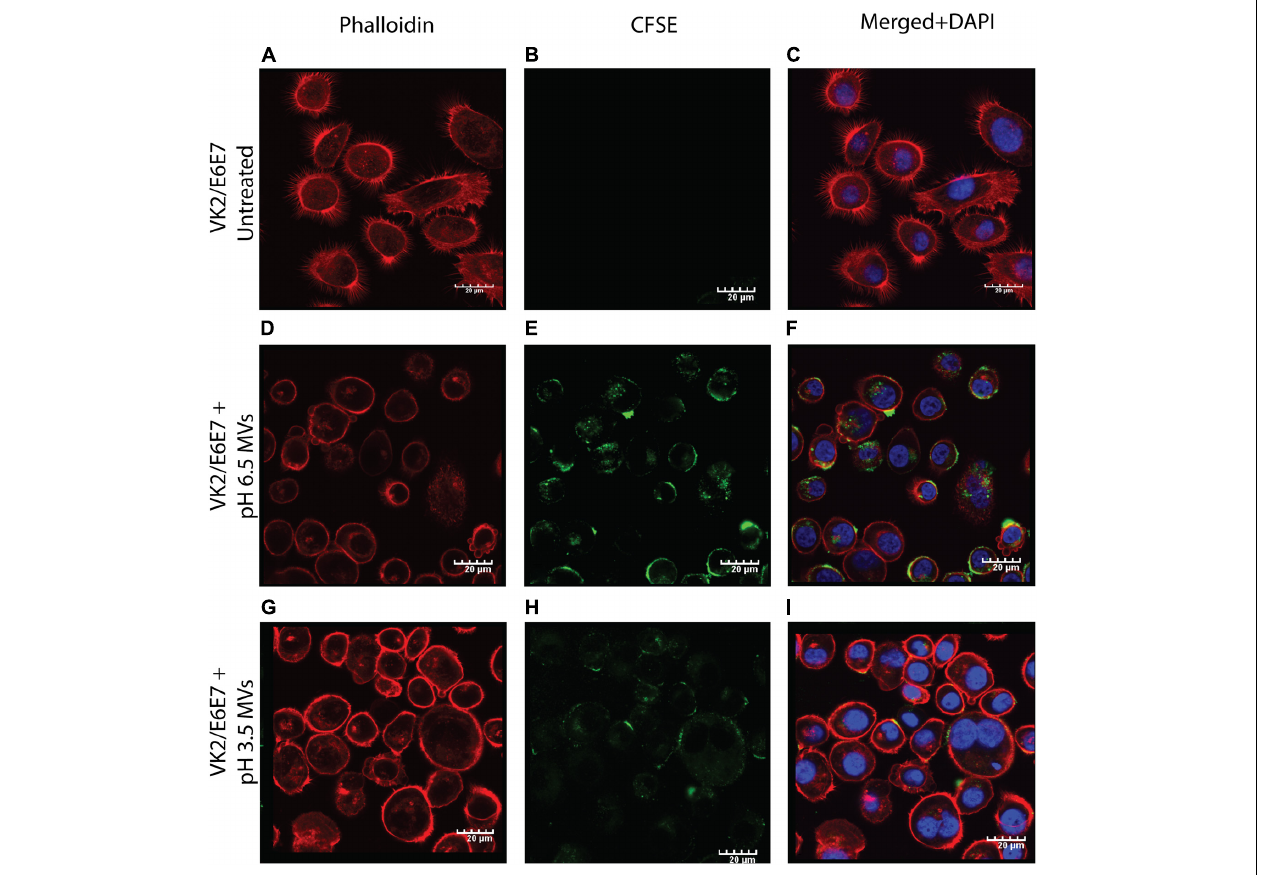
FIGURE 6 | Adherence of G. vaginalis ATCC 14019 MVs and uptake by vaginal epithelial cells, VK2. Confocal microscopy sections of phalloidin (red) stained VK2/E6E7 cells treated for 24 h with CFSE (green) stained G . vaginalis MVs obtained at pH 6.5 (D–F) and pH 3.5 (G–I) along with untreated controls (A–C) . Nuclei were stained with DAPI (blue). Scale bar 20 µ